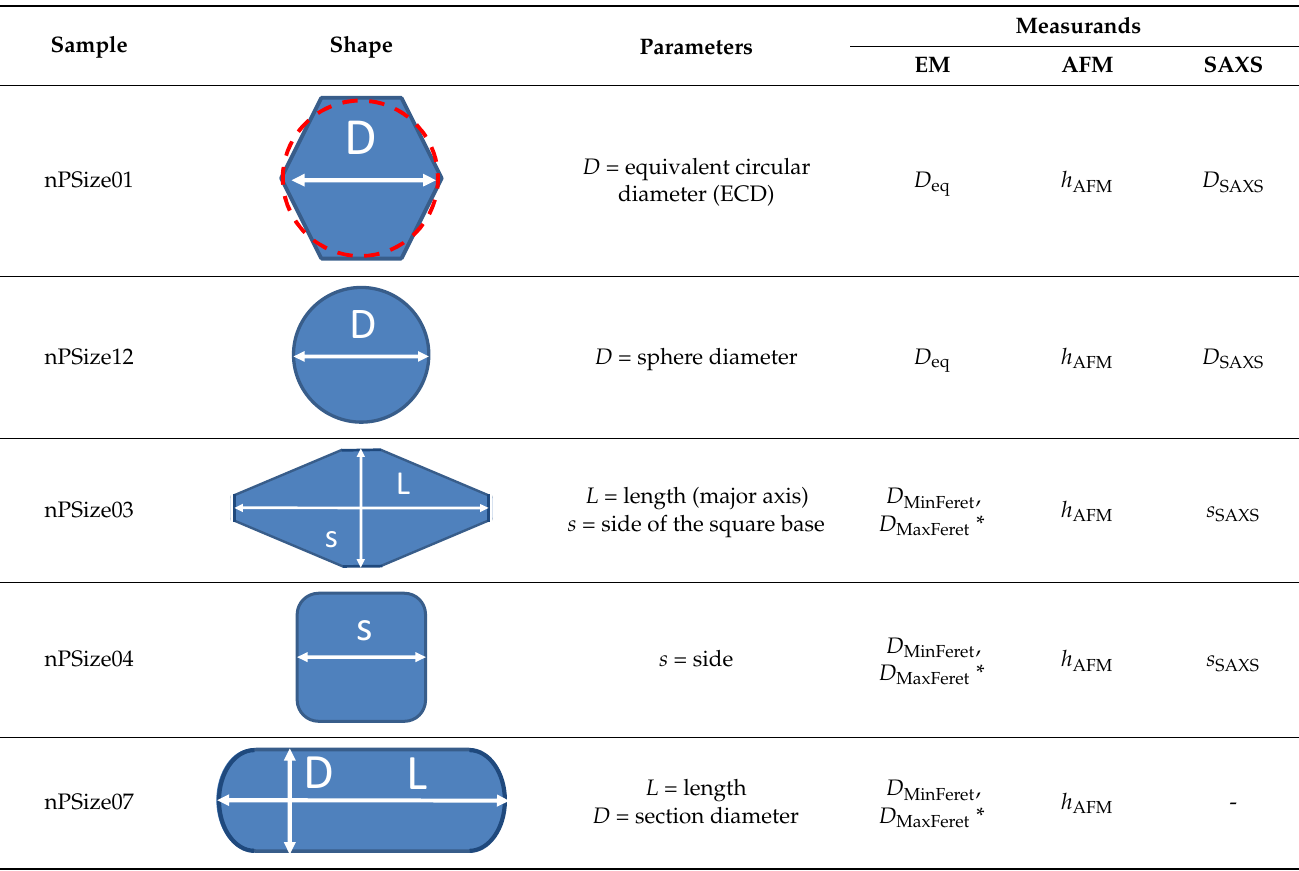
Table 7. Parameters describing the NP geometry for each NP material and the measurands.